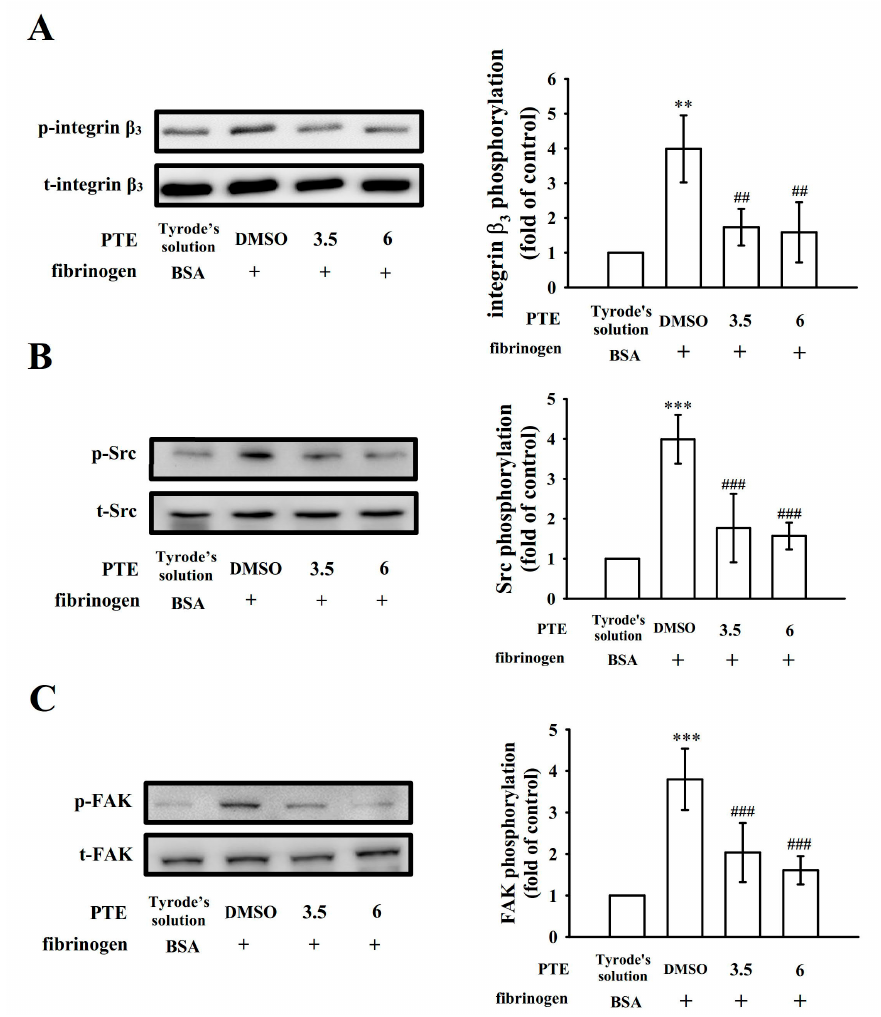
Figure 4. Effects of pterostilbene (PTE) on integrin β 3 , Src, and FAK phosphorylation in platelets exposed to immobilized fibrinogen. Washed platelets were preincubated with the solvent control (0.1% DMSO) or PTE (3.5 and 6 µ M) and subsequently activated with immobilized fibrinogen (100 µ g/mL) for determining the levels of ( A ) integrin β 3 , ( B ) Src, and ( C ) FAK phosphorylation, as described in the Materials and Methods section. Data are presented as the mean ± standard deviation ( n = 4). ** p < 0.01 and *** p < 0.001, compared with the bovine serum albumin (BSA; control); ## p < 0.01 and ### p < 0.001, compared with the 0.1% DMSO-treated